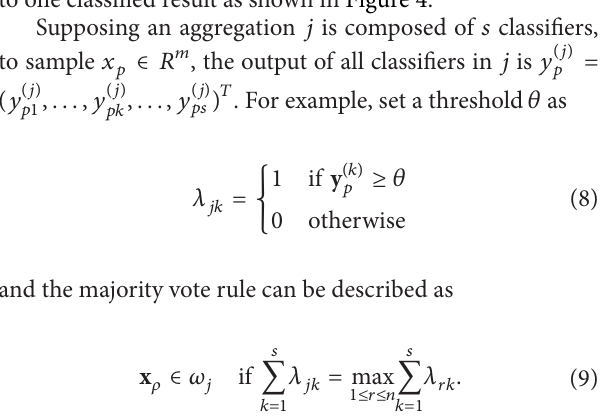
each class, and the class with the maximum votes is